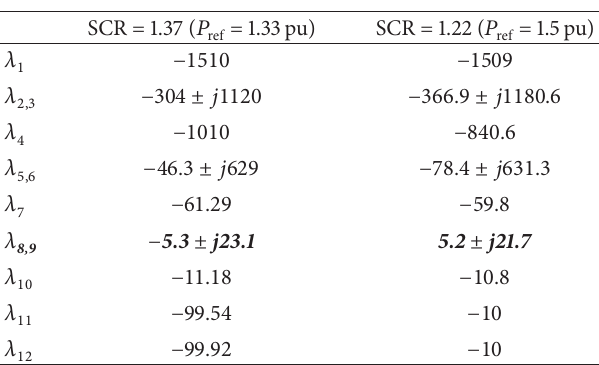
Table 2: Eigenvalues of the test model.